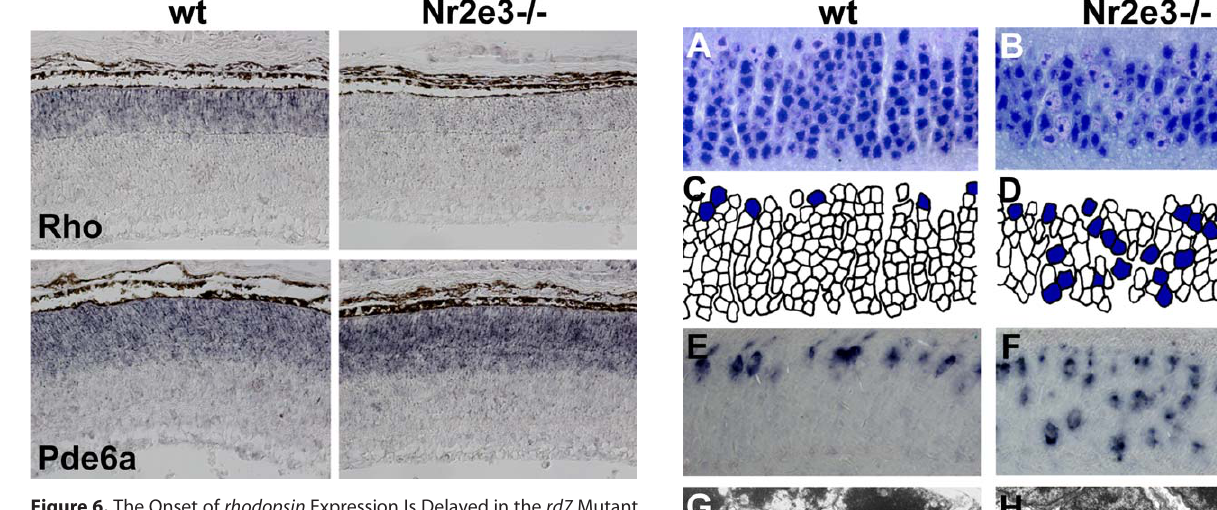
Figure 6. The Onset of rhodopsin Expression Is Delayed in the rd7 Mutant Retina Note the nearly undetectable staining for rhodopsin in this P6 mutant retina (top right). The majority of rod-specific genes did not show this delay in expression onset, as indicated by the normal amount of staining for Pde6a in the mutant at P6 (bottom images). DOI: 10.1371/journal.pgen.0010011.g006